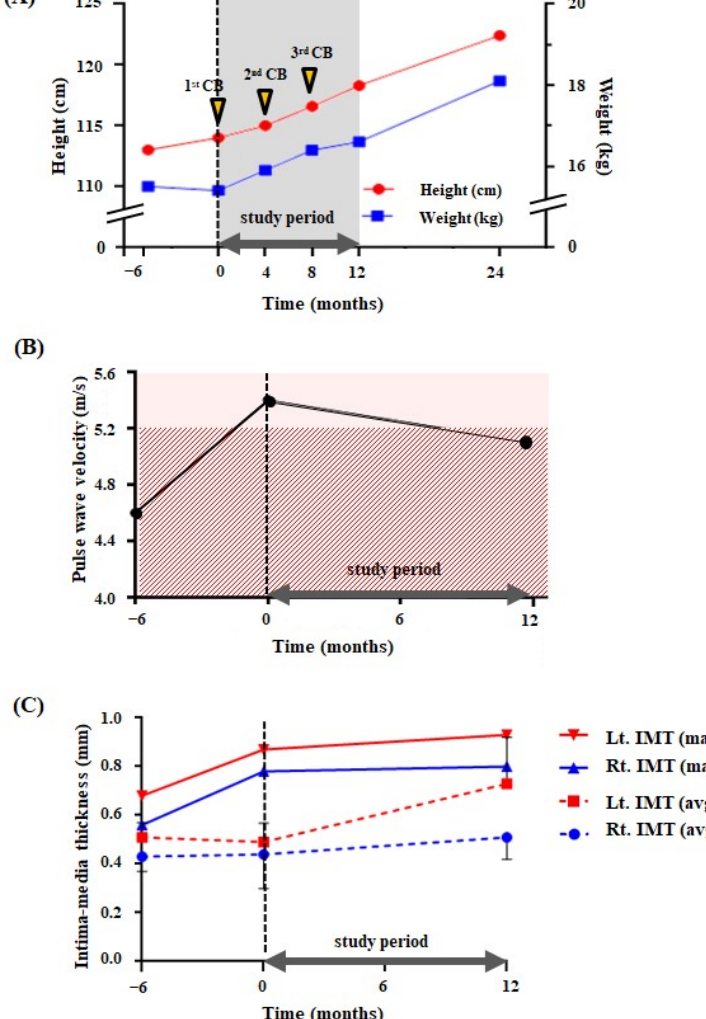
Figure 1. Changes before and after the cord blood cell therapy. ( A ) the height and the weight, ( B ) the changes of PWV, and ( C ) the changes of IMT through the study period. The dotted vertical line (0 months) shows the initiation of the trial. ( A ) The red dots show the height, and the blue dots show the weight of the patient. The yellow arrow represents each cord blood infusion, gray shaded area represents the 12 months of trial and follow-up period. ( B ) Pink shaded area represents